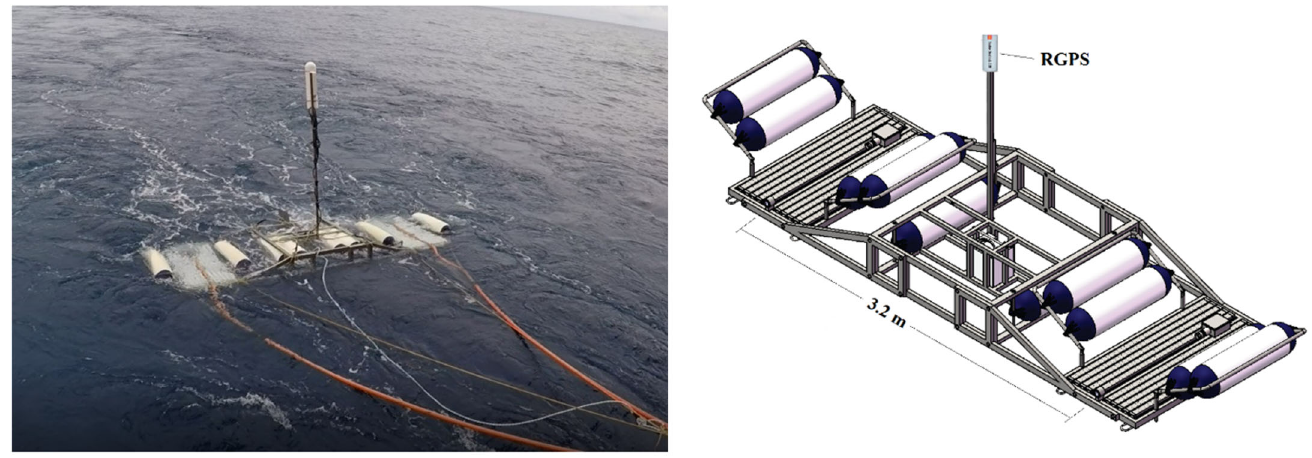
Figure 4. Results of the source wavelet test. ( a ) oscillogram of source wavelet; ( b ) frequency spec ‐ trum of source wavelet. 2.2. High ‐ Resolution Seismic Streamer A small ‐ group ‐ interval high ‐ resolution seismic streamer consists of a leading sec ‐ tion, a photoelectric conversion unit, a front elastic section, a data transmission unit, a working section, a rear elastic section, and a trailing transition section. The leading section is an armored photoelectric composite cable, which transmits commands and signals through optical fibers and supplies power to each part of the ca ‐ ble through electrical wires; the photoelectric conversion unit converts the optical signal commands of the multichannel seismic data acquisition unit into electrical signals and transmits them to the working section. The collected electrical signals are converted into optical signals and transmitted to the streamer controller and the multichannel seismic data acquisition unit; the front elastic section connects the leading section and the work ‐ ing section to reduce the influence of ship vibration on the working section; the data transmission unit is located in the elastic section before the connection segment and be ‐ tween two work sections. The data transmission unit is used to collect the artificial re ‐ flection seismic signals collected in the working section and send them to the photoelec ‐ tric conversion unit; the working section consists of multiple sets of hydrophone combi ‐